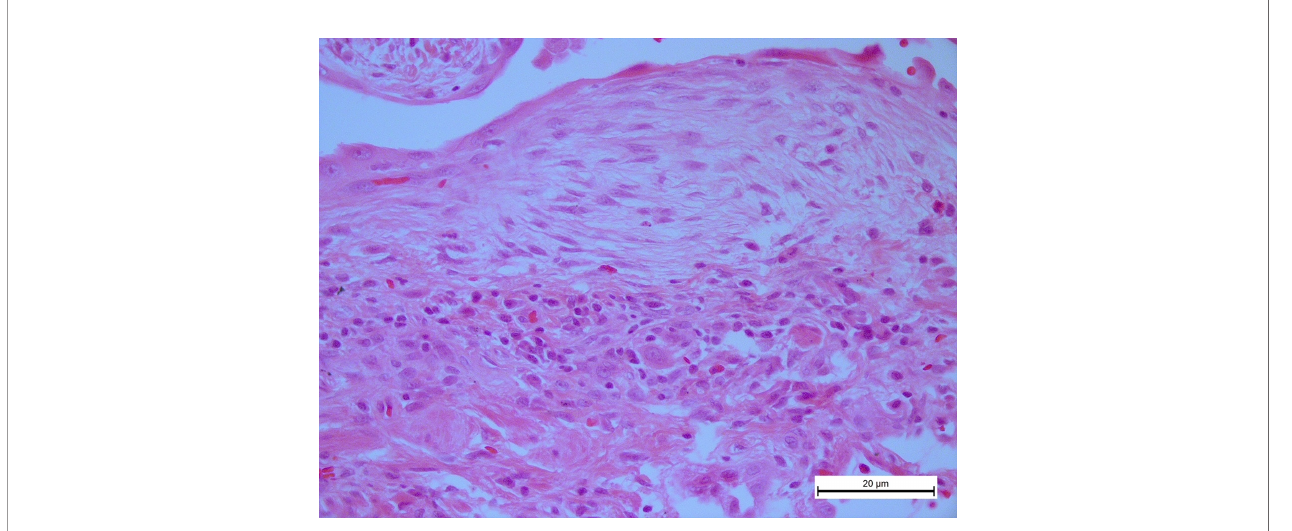
FIGURE 1 | In idiopathic pulmonary fi brosis, T cells are virtually absent inside the fi broblastic foci. A photomicrograph representative from the lung tissue of an idiopathic pulmonary fi brosis (IPF) patient stained with hematoxylin and eosin showing numerous in fl ammatory cells, primarily lymphocytes around a typical fi broblastic focus, original magni fi cation